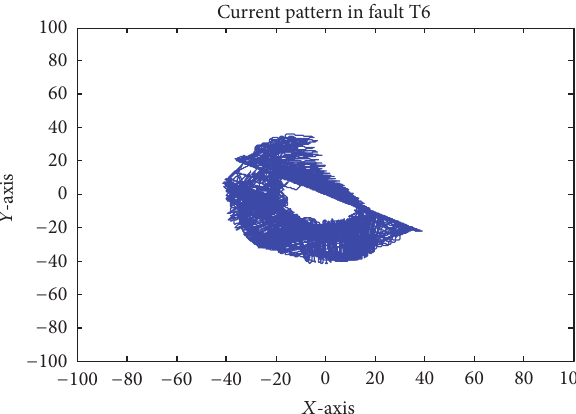
Figure 11: 𝛼 - 𝛽 transformed current pattern graph for system in single fault mode